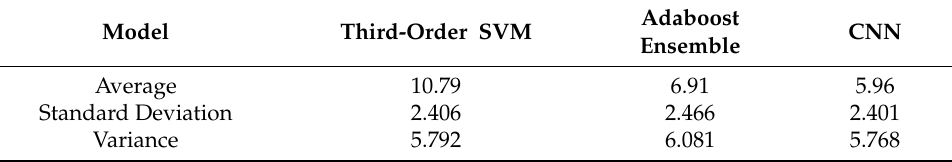
Table 3. Averages, standard deviations, and variances of first detection time for the three